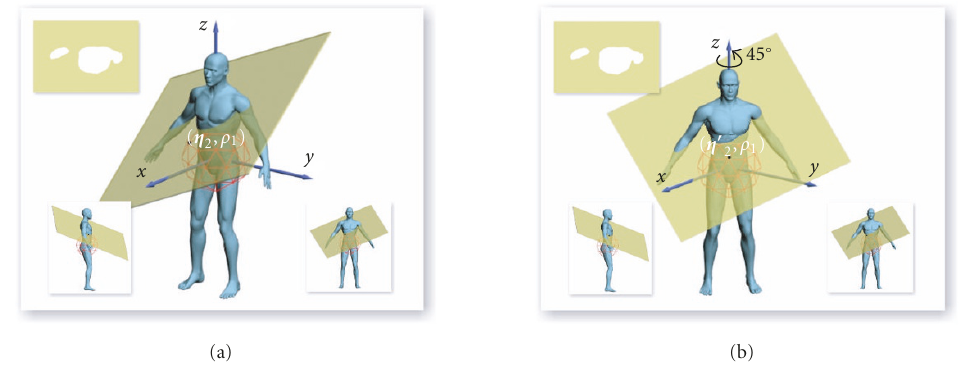
Figure 2: Rotation of f ( x ) rotates F ( η , ρ ), without rotating the corresponding f ( i , j ) (upper left image). Thus, F ( η